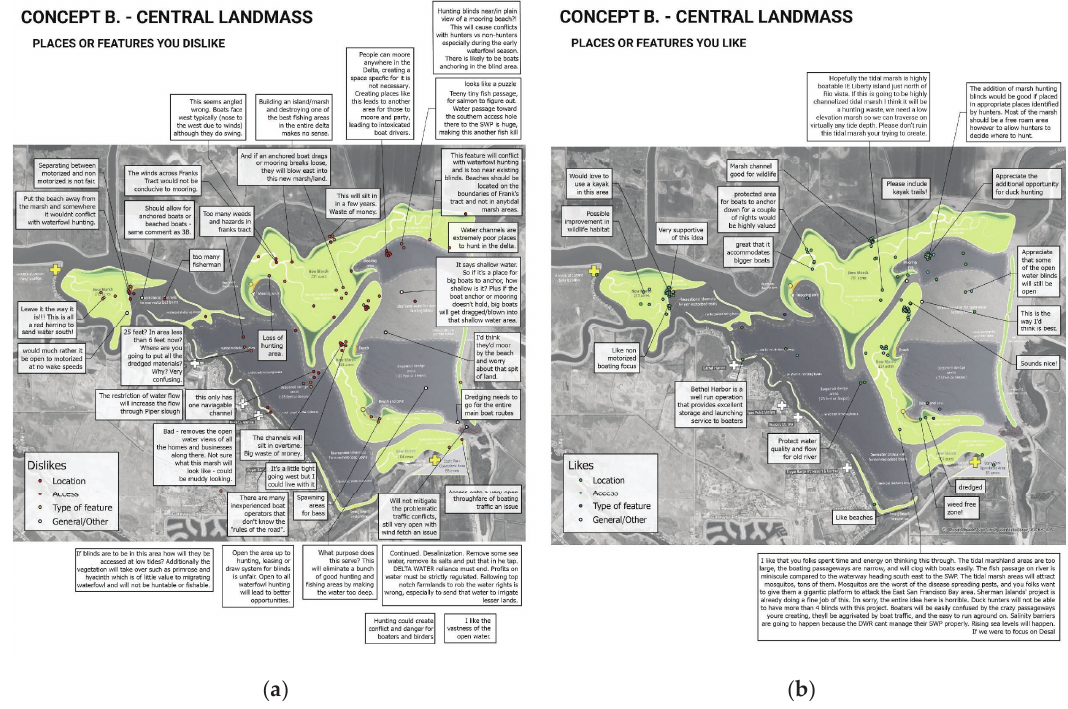
Figure 16. Concept B (the preferred concept)-Central Landmass community comments. ( a ) Places or features you dislike for Concept B ( b ) Places or features you like for Concept